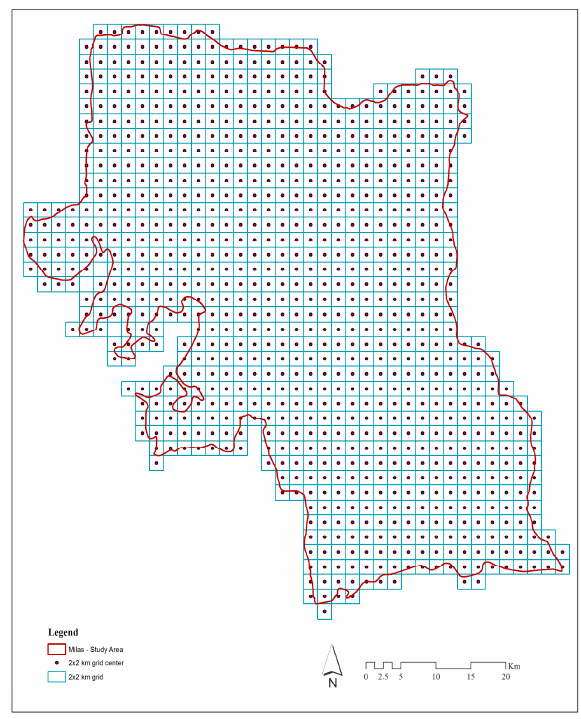
Figure 7. Grid centers without a background.